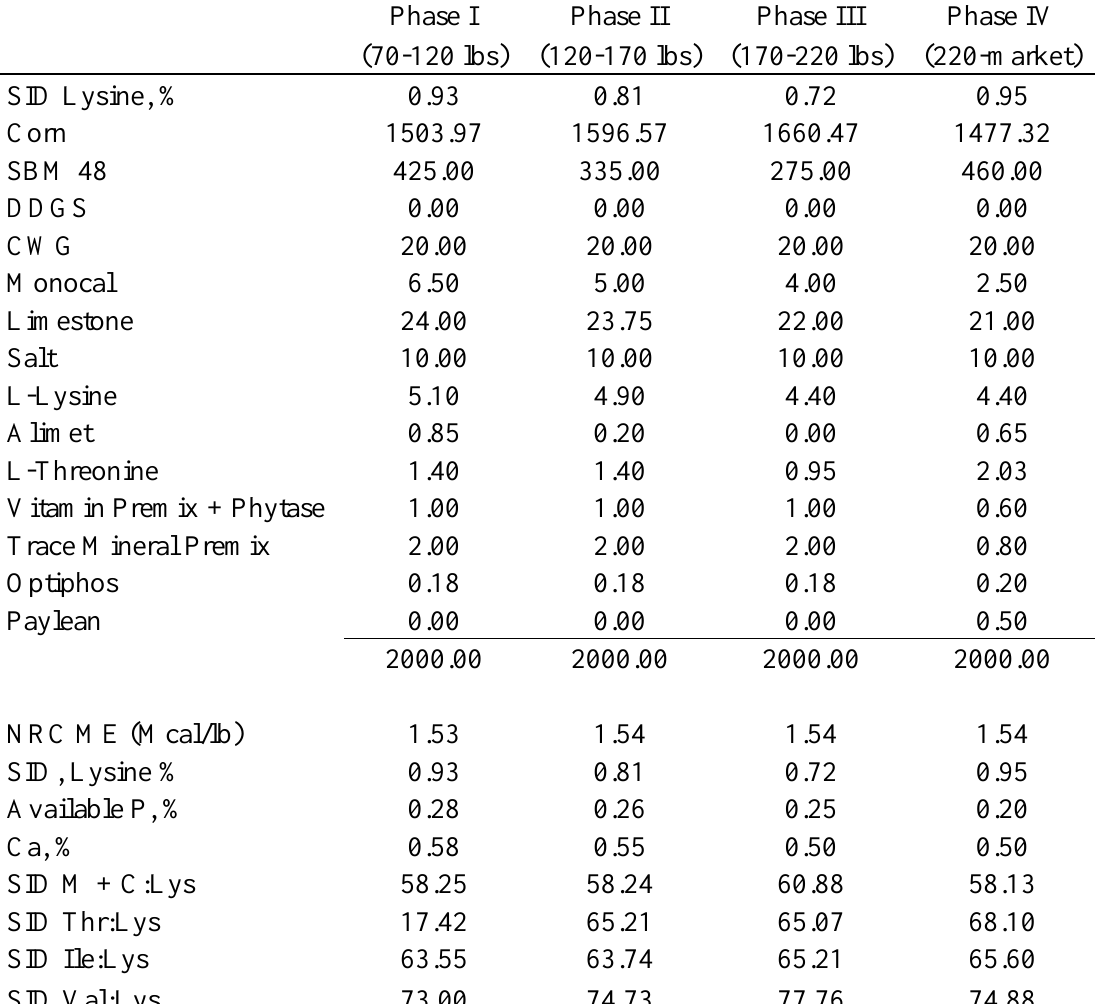
Table 1 . Composition of the grower-finisher control